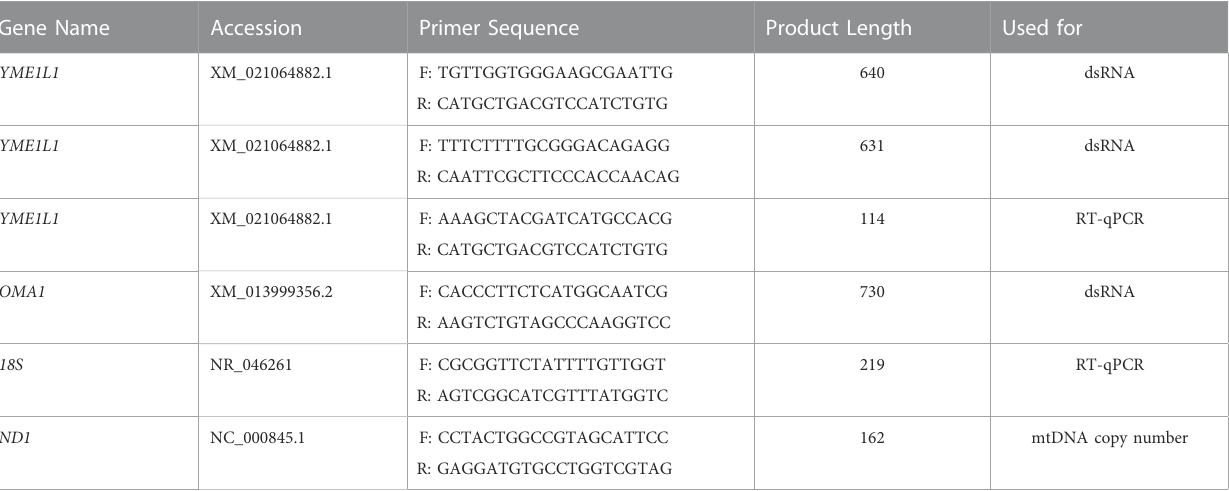
TABLE 1 Summary of PCR